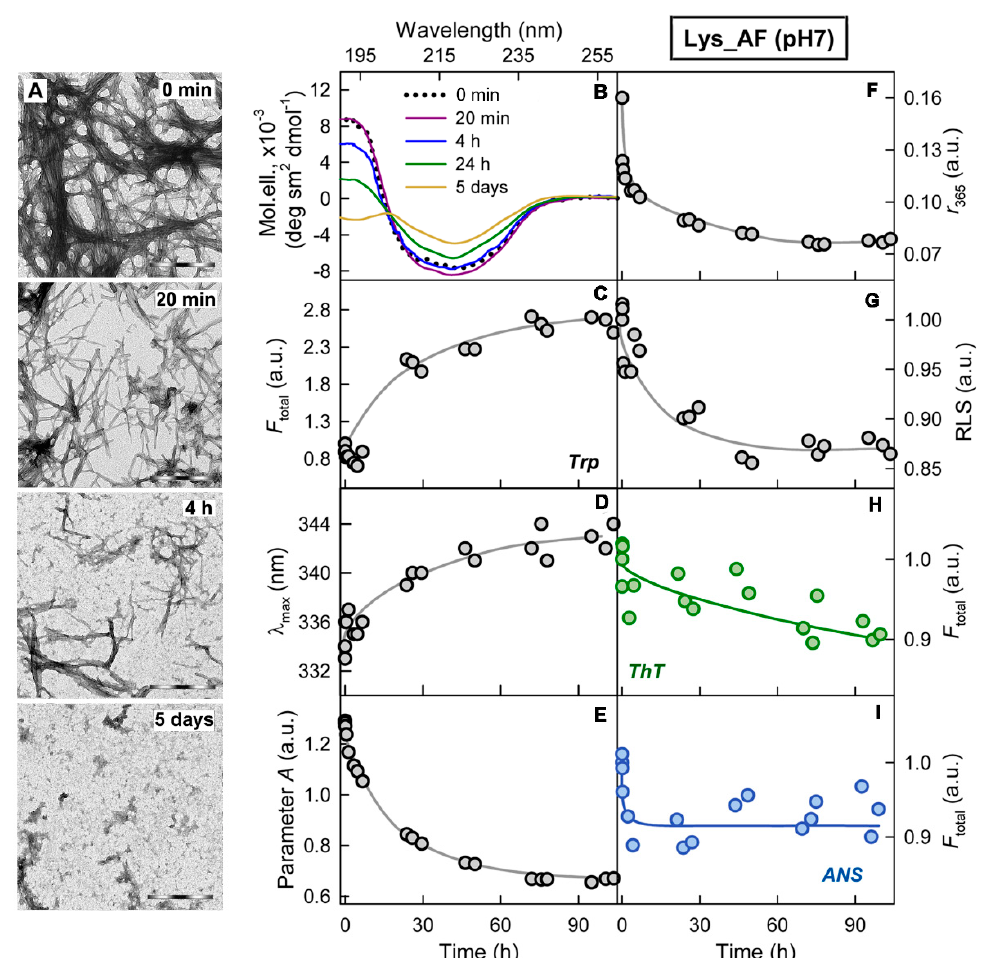
Figure 1. Trypsin-induced degradation of amyloid fibrils formed from lysozyme at pH 7. ( A ) The electron micrographs of amyloid fibrils in the absence and at different time points after the addition of trypsin to the samples. Scale bars are equal to 1 µ m. ( B ) Changes in far UV CD spectra of amyloid samples. ( C ) Changes in total fluorescence intensity of amyloid fibrils at the excitation wavelength of 295 nm. ( D ) Changes in wavelength of the fluorescence spectrum maximum of amyloid fibrils ( λ max ). ( E ) Changes in parameter A of amyloid fibrils, λ ex = 295 nm. ( F ) Changes in fluorescence anisotropy of amyloid fibrils, λ ex = 295 nm, and λ em = 365 nm. ( G ) Changes in Rayleigh Light Scattering of amyloid fibrils. ( H ) Changes in the total fluorescence intensity of ThT and ( I ) ANS in the presence of amyloid fibrils. The values at the panels ( C , H , I ) are normalized to the values for fibrils in the absence of the protease. The experiments were performed under physiological conditions (in 20 mM sodium phosphate buffer solution, pH 7.4) and weight ratio of fibrils to trypsin was kept at 125:1. The standard error of the mean is determined for a confidence interval of 0.95 and does not exceed 10%.